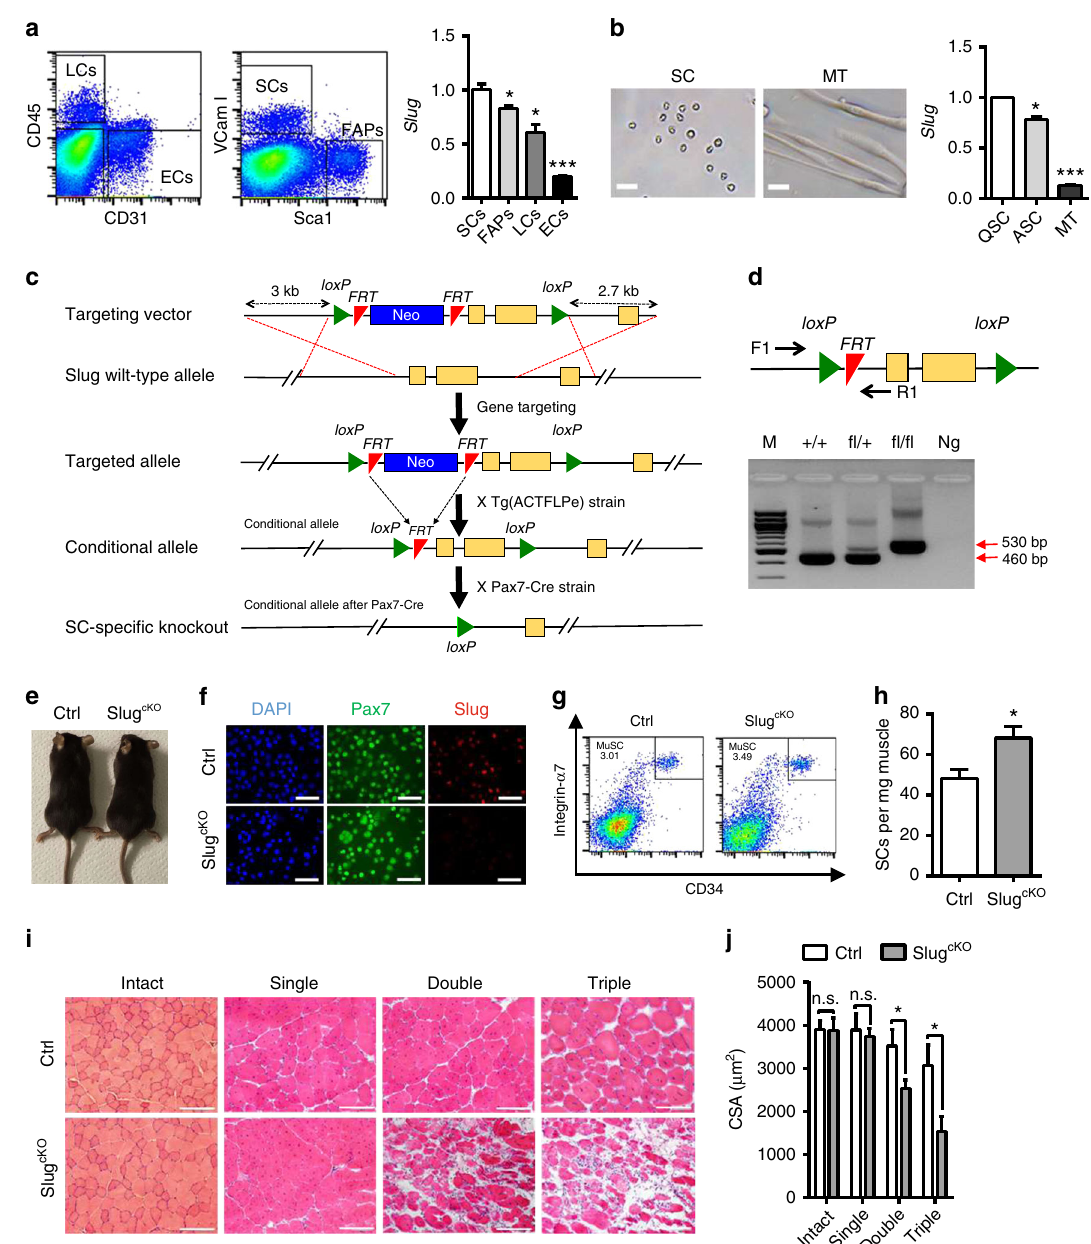
Fig. 2 SC-speci fi c Loss of Slug Impairs Muscle Regeneration. a Slug expression in different muscle resident cells. Left, representative fl ow cytometric gating of SCs (CD31 − CD45 − Scal1 − Vcam I + ), pan-lymphocytes (LCs, CD45 + ), epithelial cells (ECs, CD31 + ), and fi bro-adipogenic progenitors (FAPs, CD31 − CD45 − Scal1 + ) from freshly prepared skeletal muscle cells. Right, qPCR analysis of Slug expression. * p < 0.05, ** p < 0.01, *** p < 0.001 by student ’ s t -test. b Quanti fi cation of Slug expression in undifferentiated and differentiated SCs. Left, representative images of SCs and myotubes. Scale bar, 100 µ m. Right, qPCR analysis of Slug expression. * p < 0.05, *** p < 0.001 by student ’ s t -test. QSC, quiescent satellite cell; ASC, activated satellite cells upon culture in growth medium for 3 days; MT, myotube. c Gene targeting strategy for generation of SC-speci fi c Slug knockout mice. d Diagram of Slug -speci fi c primer design for genotyping PCR. M. DNA marker; Ng negative control for PCR. e Comparison of adult Slug fl / fl Pax7 Cre/ + ( Slug cKO ) and Slug fl / + Pax7 Cre/ + (Ctrl). f Immuno fl uorescence staining of Slug in SCs of Slug cKO and Ctrl mice (n = 3 mice). Scale bar, 100 µ m. g Frequency of SCs in Slug cKO and Ctrl mice.